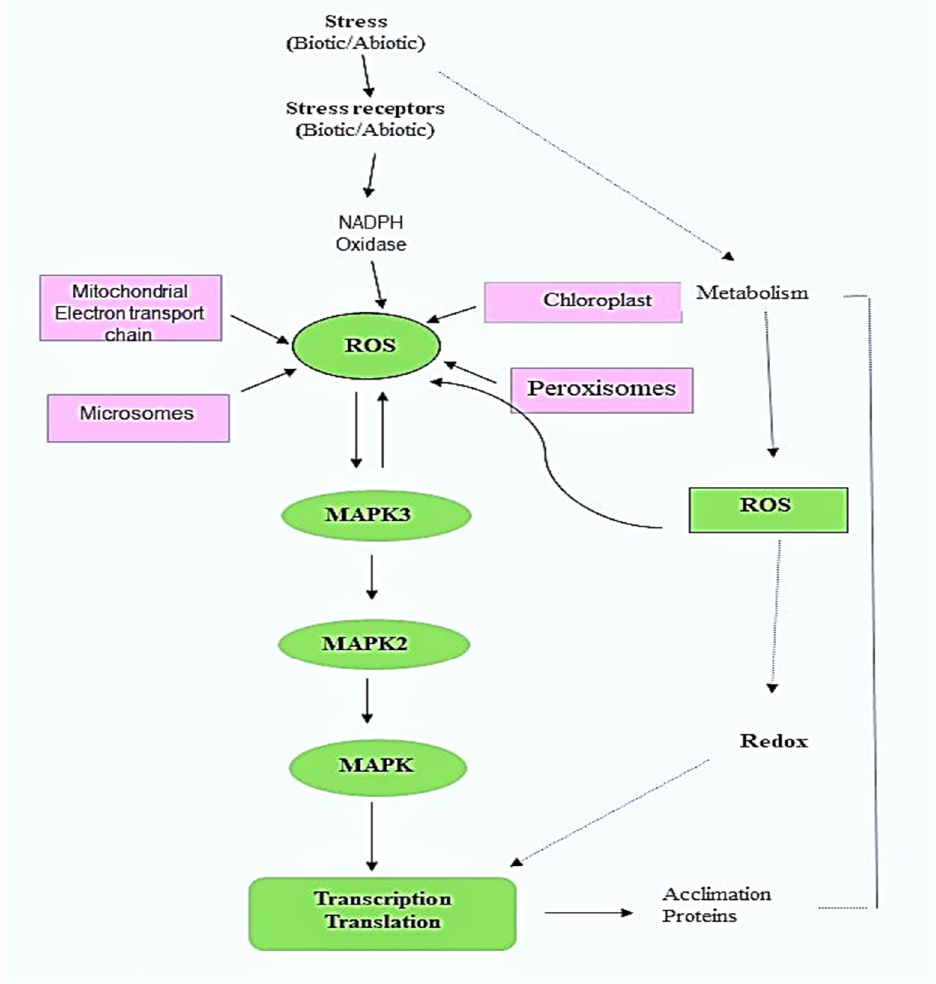
Figure 1. ROS signaling, the activation of the MAPK cascade and redox ROS homeostasis in the cell. In biotic and abiotic stressors, the reactive oxygen species (ROS) signaling pathway is regulated by mitogen-activated protein kinases (MAPK). ROS is a common messenger that is produced in response to both the stress response and the MAPK cascade. Despite having a similar MAPK signaling regulator, the plant's reaction to both stressors is distinct.